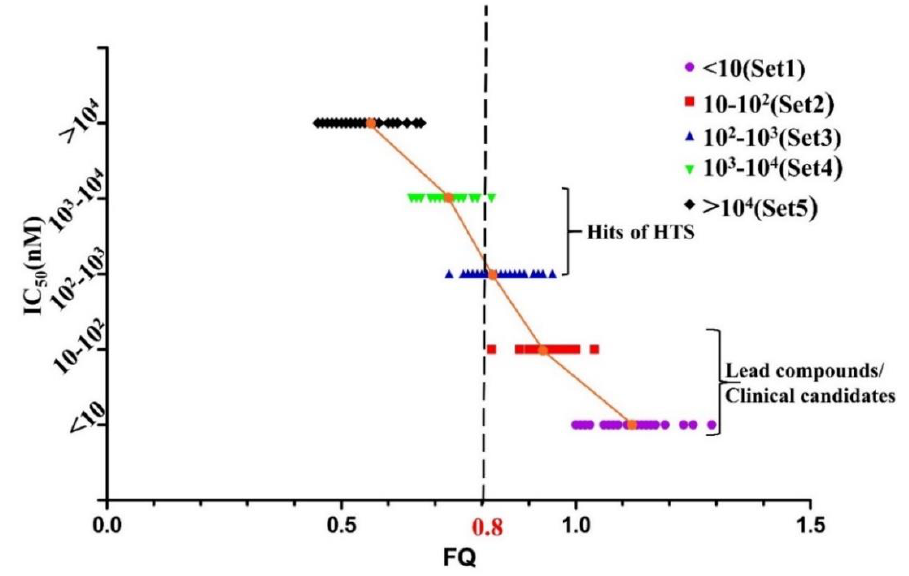
Figure 6. The graph of potency (IC 50 ) vs. FQ of 156 MDM2/p53 PPIIs. The cut-off is represented by a black dashed line. The mean value of FQ in Sets 1–5 is relatively 1.11, 0.94, 0.84, 0.73 and 0.55.